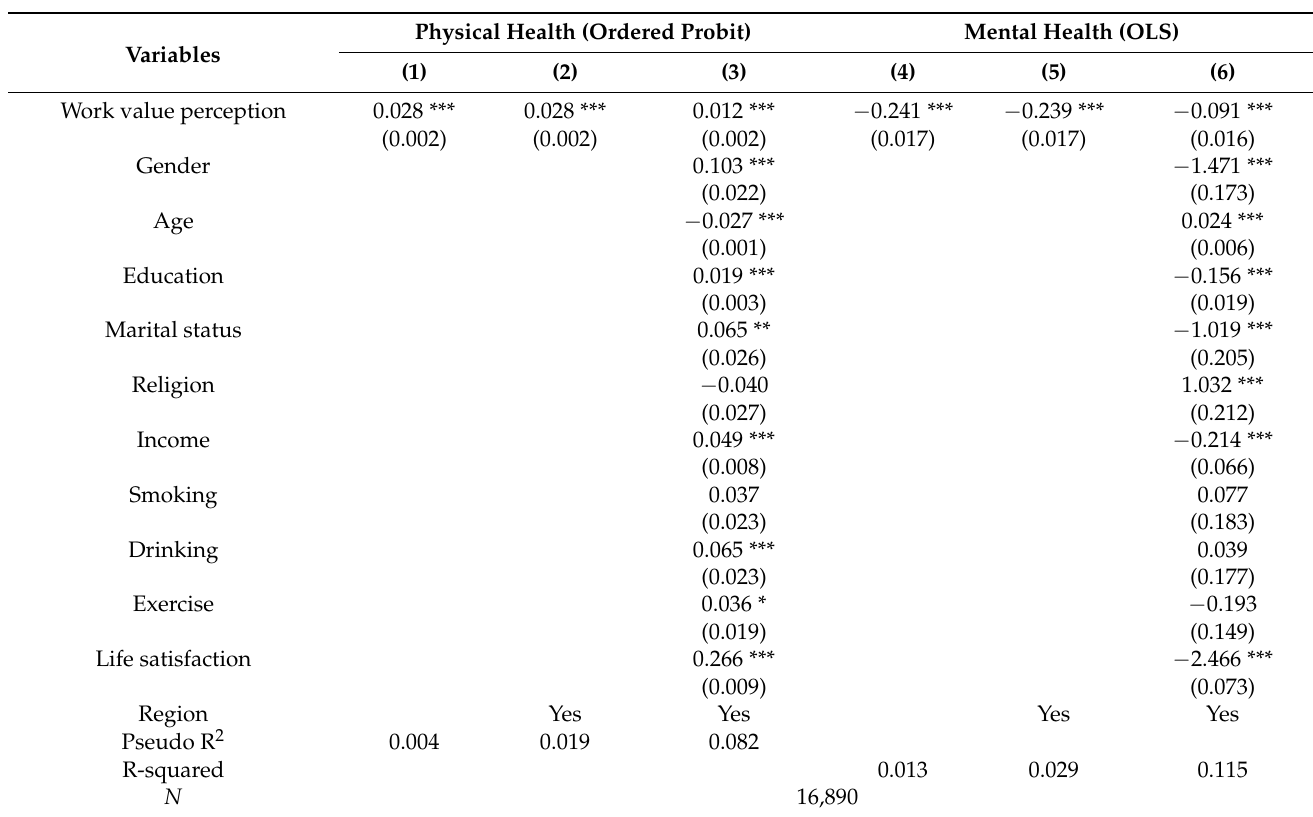
Table 2. Benchmark